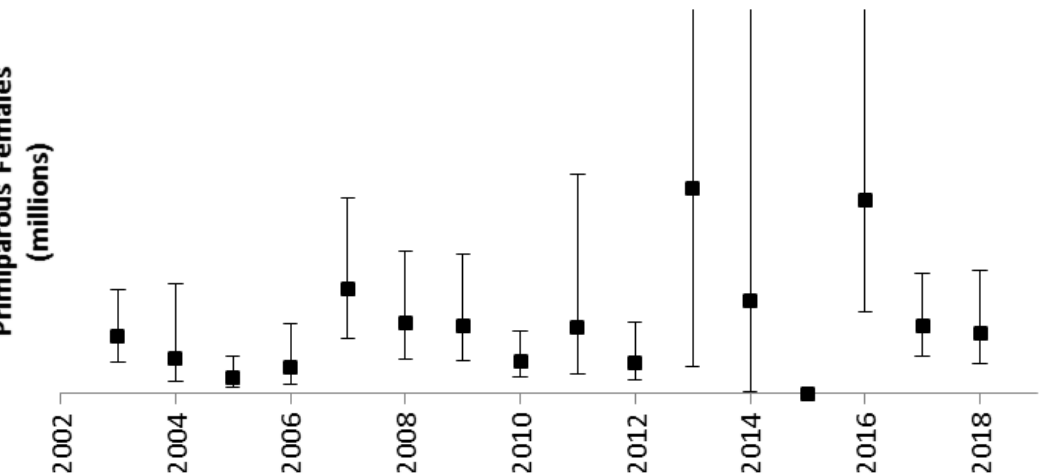
Figure 4. CMSA model estimated primiparous female abundance with lower and upper 95% confidence limits. Upper confidence limits for 2013, 2014, and 2016 extend beyond y-axis with values of CONFIDENTIAL. Y-axis values have been removed due to CONFIDENTIAL data.